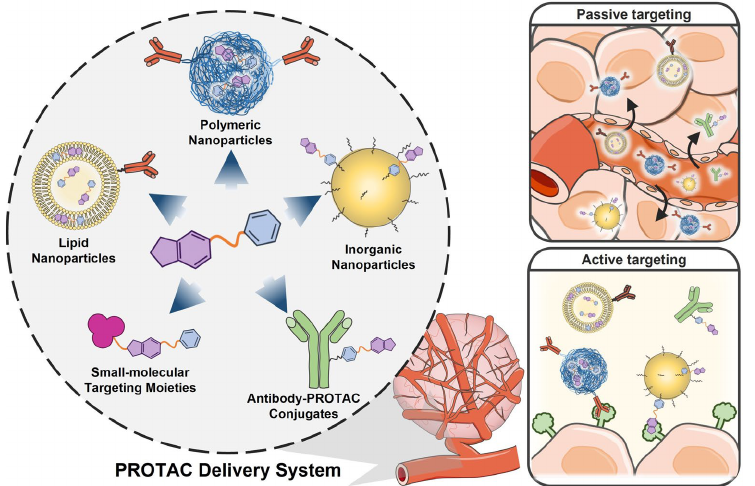
Figure 2. Carriers for PROTAC delivery. Various types of carriers including organic/inorganic nanoparticles, small-molecular targeting moieties, and antibodies/aptamers have been explored for PROTAC delivery. They regulate the pharmacokinetic properties of PROTACs, concurrently increasing their tumor-specific accumulation levels through passive and/or active targeting methods.